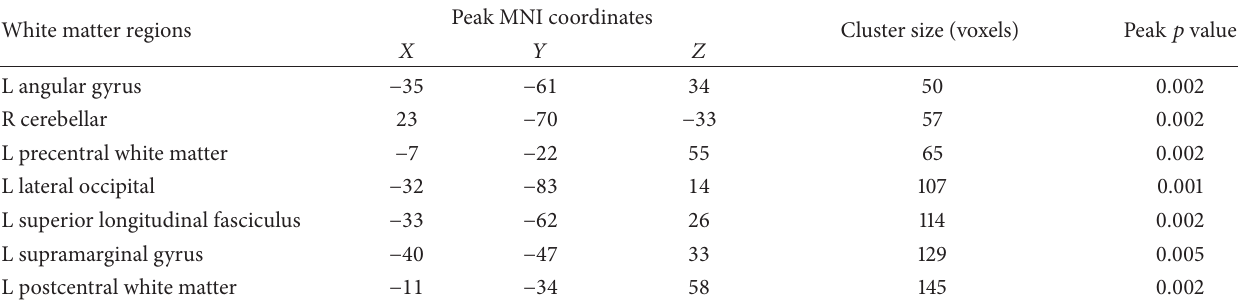
Table 2: White matter regions showing significantly decreased fractional anisotropy in SCI